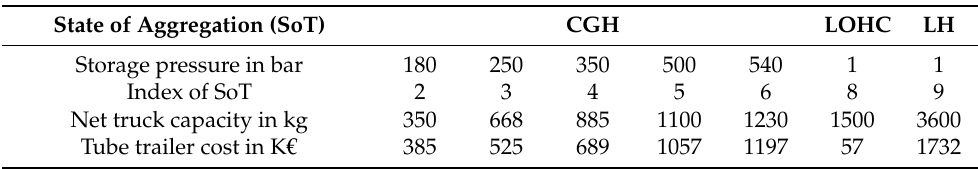
Table 5. Assumption for tube trailer used to store and transport from own calculation and sources [28,29,62]. State of Aggregation